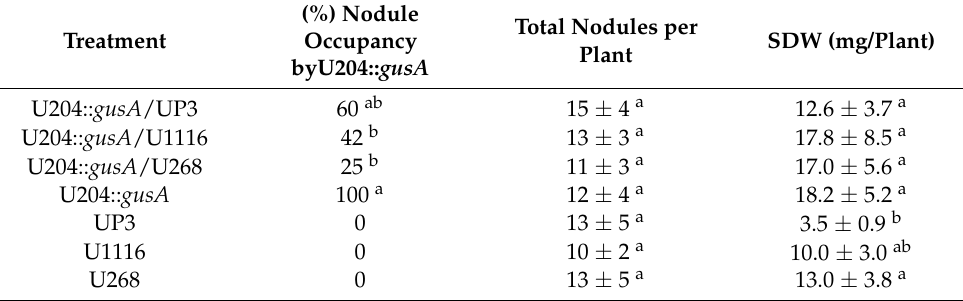
Table 4. Nodulation competitiveness test 1. Nodule occupancy by strains UP3, U268, and U1116 in competition with U204:: gusA at a ratio 1:1. Controls corresponded to seeds inoculated with each strain individually (106 CFU/seed). SDW, shoot dry weight, and the total number of nodules in each treatment at shown. Results (mean ± standard deviation) are from one of three independent experiments with a similar trend. Different letters indicate statistical differences between values within each column ( p <